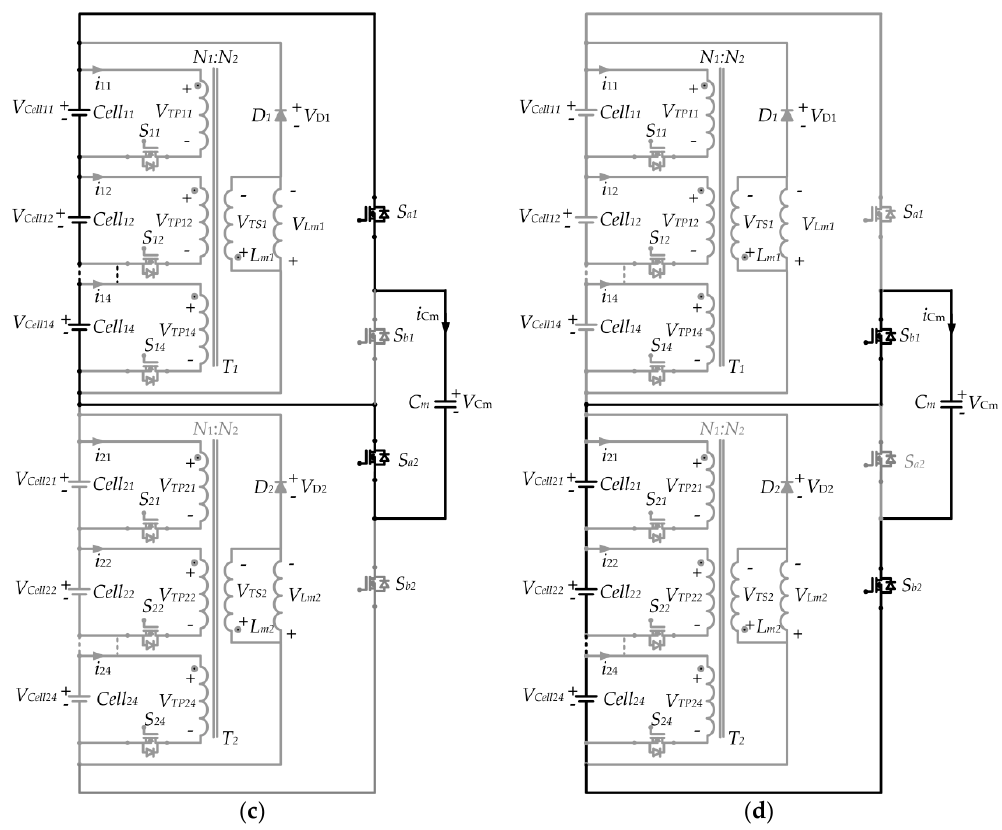
Figure 10. Operating modes of the proposed MCBC: ( a ) Mode 1; ( b ) Mode 2; ( c ) Mode 3; ( d ) Mode 4.